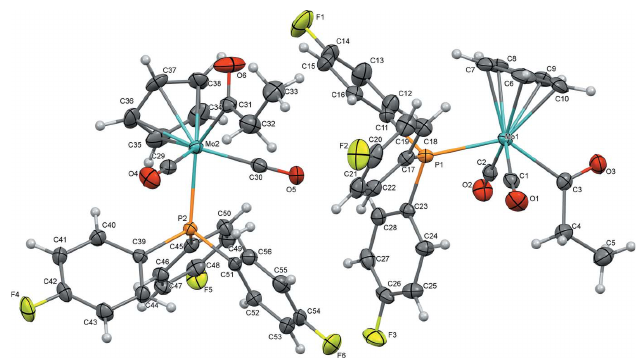
Figure 2 Molecular structure of ( 2 ) with ellipsoids at 50%